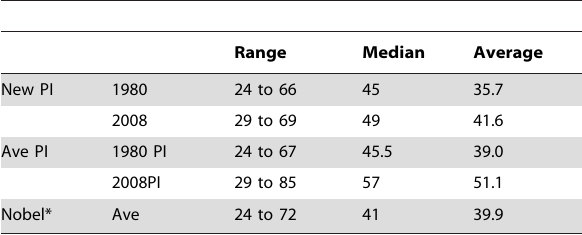
Table 1. Range, Median and Averages of NIH PIs and First- time Recipients and Nobel Prize